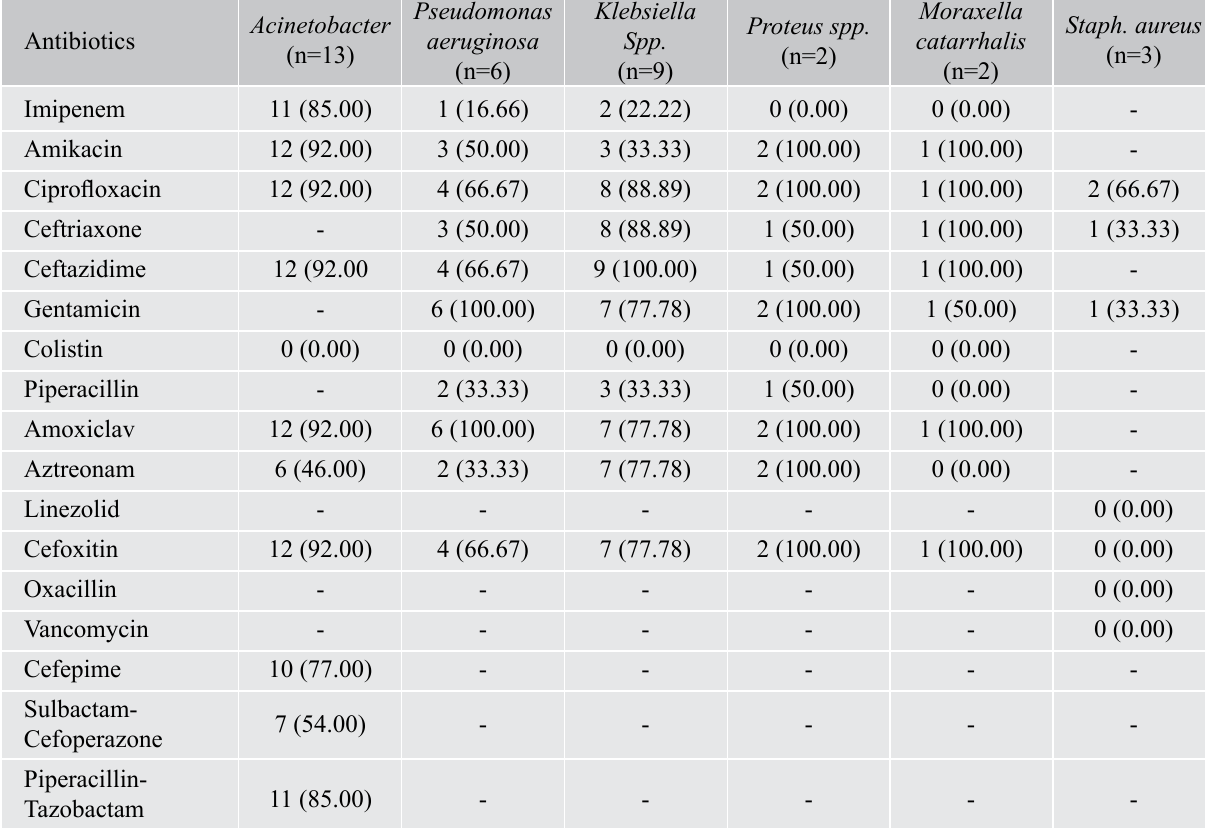
Table III: Antibiotic resistance pattern of major isolated bacteria to different antibiotics Antibiotics